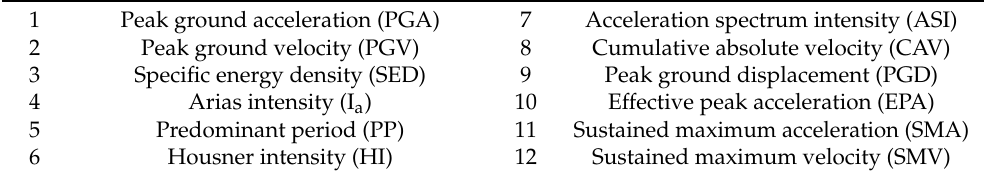
Table 5. The selected seismic parameters for the input vectors of MLP